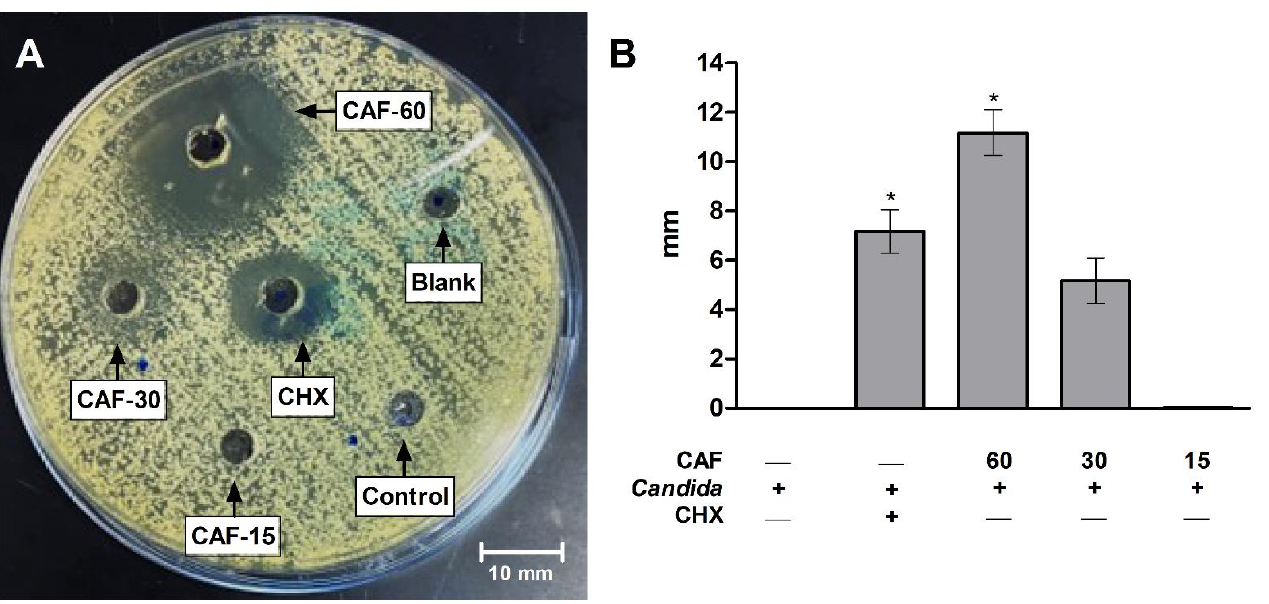
Figure 3. Agar-well diffusion method for caffeine (CAF) effects against C. albicans growth. ( A ) Different concentrations of CAF including 15 mg/mL, 30 mg/mL, and 60 mg/mL were tested. The higher two concentrations of CAF (30 and 60 mg/mL) showed the most prominent inhibition of the fungal growth as compared with control containing PBS alone, blank containing distilled water, and standard therapy containing chlorhexidine (CHX). ( B ) Measurements of zone of inhibition (mm). Data are expressed as mean ± SD ( n = 3) and statistically analyzed using Kruskal–Wallis test and Dunn’s post hoc test. The significance was considered when * p ≤ 0 .05 as compared with control.